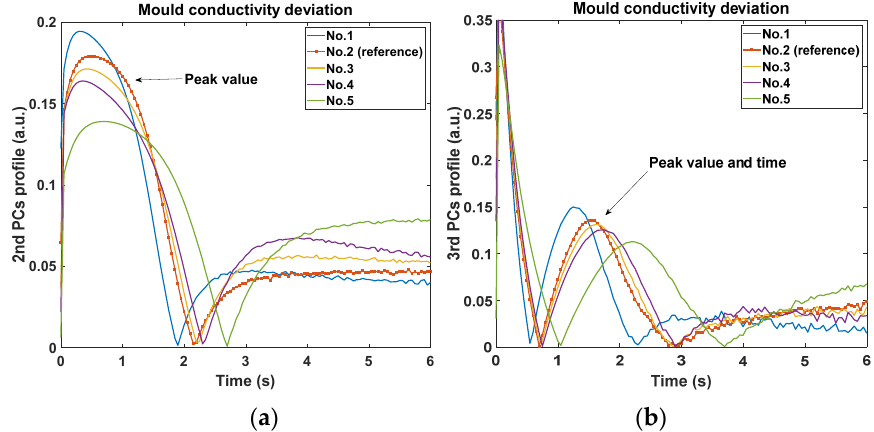
Figure 9. Comparison of features with different values of mould conductivity; ( a ) the 2nd principal component profiles; ( b ) the 3rd principal component profiles.